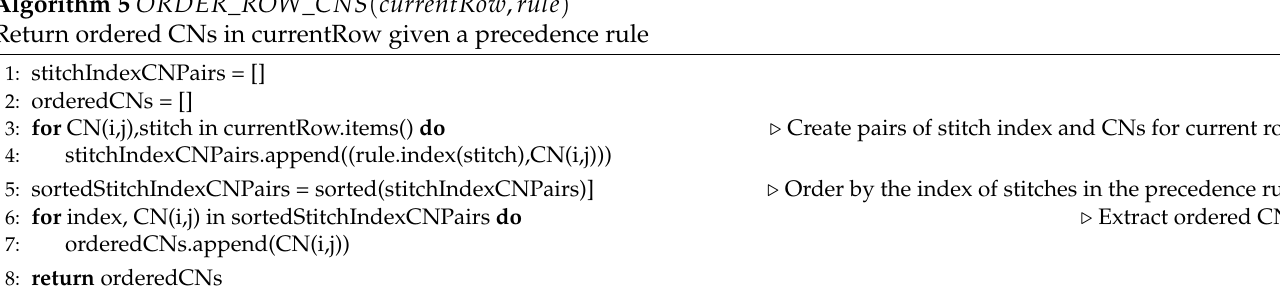
Algorithm 5 ORDER _ ROW _ CNS ( currentRow , rule ) Return ordered CNs in currentRow given a precedence